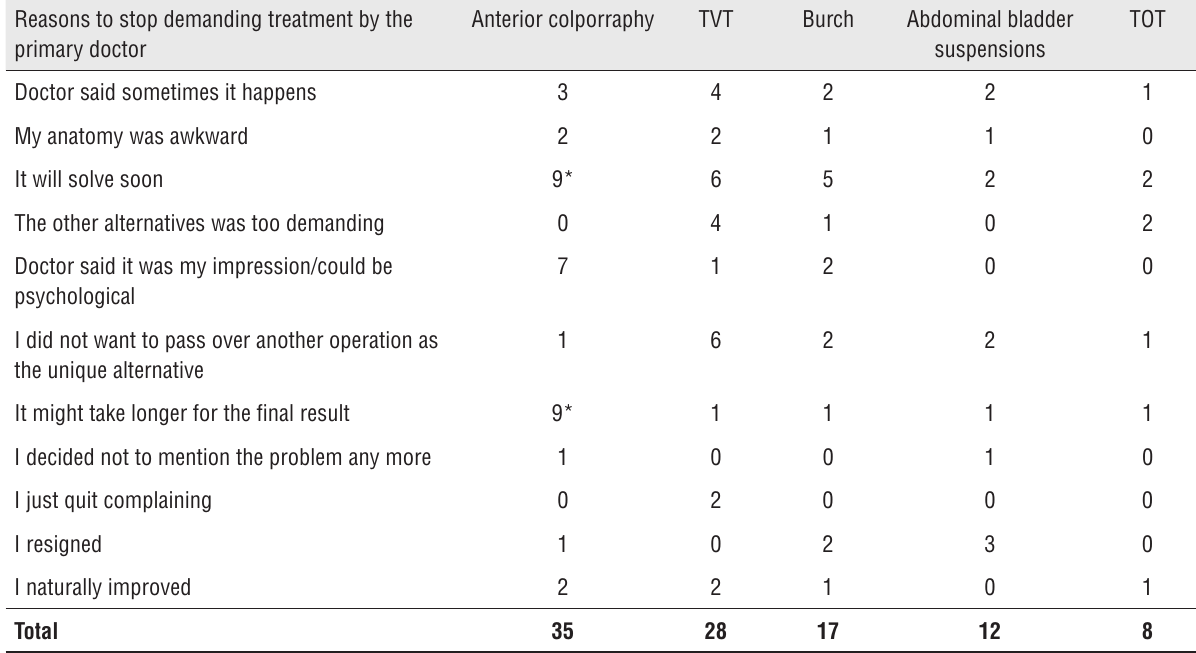
Table 4 – Reasons why you stopped inquiring solution to the doctor that primarily treated you. Reasons to stop demanding treatment by